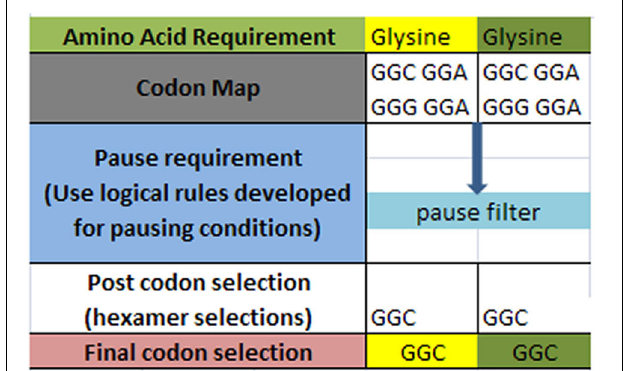
FIGURE 3 | Hypothetical amino acid/TP selection example. Top row requires the given partial amino acid series for a given protein (left to right). The second row specifies the standard codon map for its particular amino acid. The pause requirement row specifies that a translation pause is necessary for the glycine to glycine junction for proper pre-folding. The rules for pausing are invoked to filter the redundant glycine codons. The post codon selection row results from filtering the codon map above for specified TP condition. The final codon selection row is the final codon selection from the row immediately above (may or may not be a function of other filters). This results in writing the ORF of a hypothetical gene.